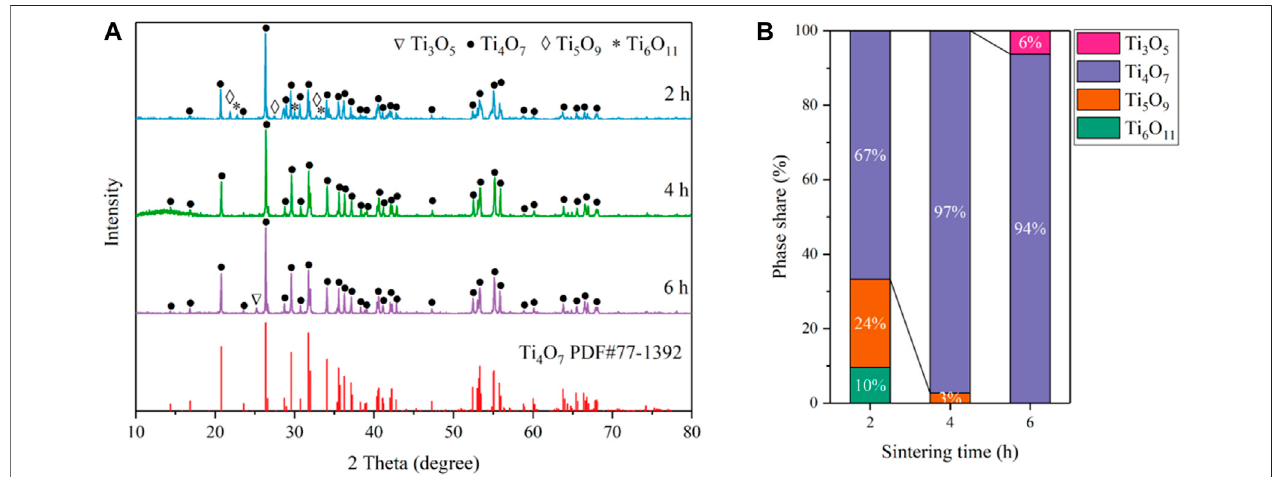
FIGURE 2 | (A) XRD patterns of the as-prepared samples obtained at 1333 K for 2, 4, and 6 h; (B) Phase composition percentage.